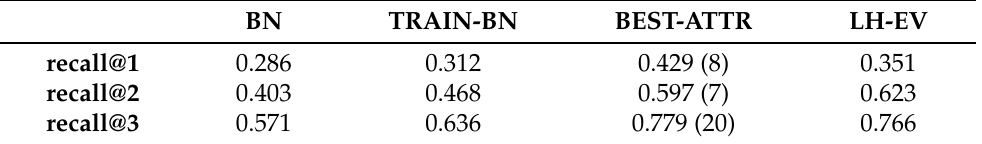
Table 5. Recall@ k for MUS considering the original expert-defined BN-DSSApple (BN), the BN- DSSApple trained on MUS data (TRAIN-BN), the incremental best attribute selection (BEST-ATTR), and the BN-DSSApple refined by likelihood evidence (LH-EV). For the BEST-ATTR column, we report the results for the optimal attribute set, with the number of selected attributes in